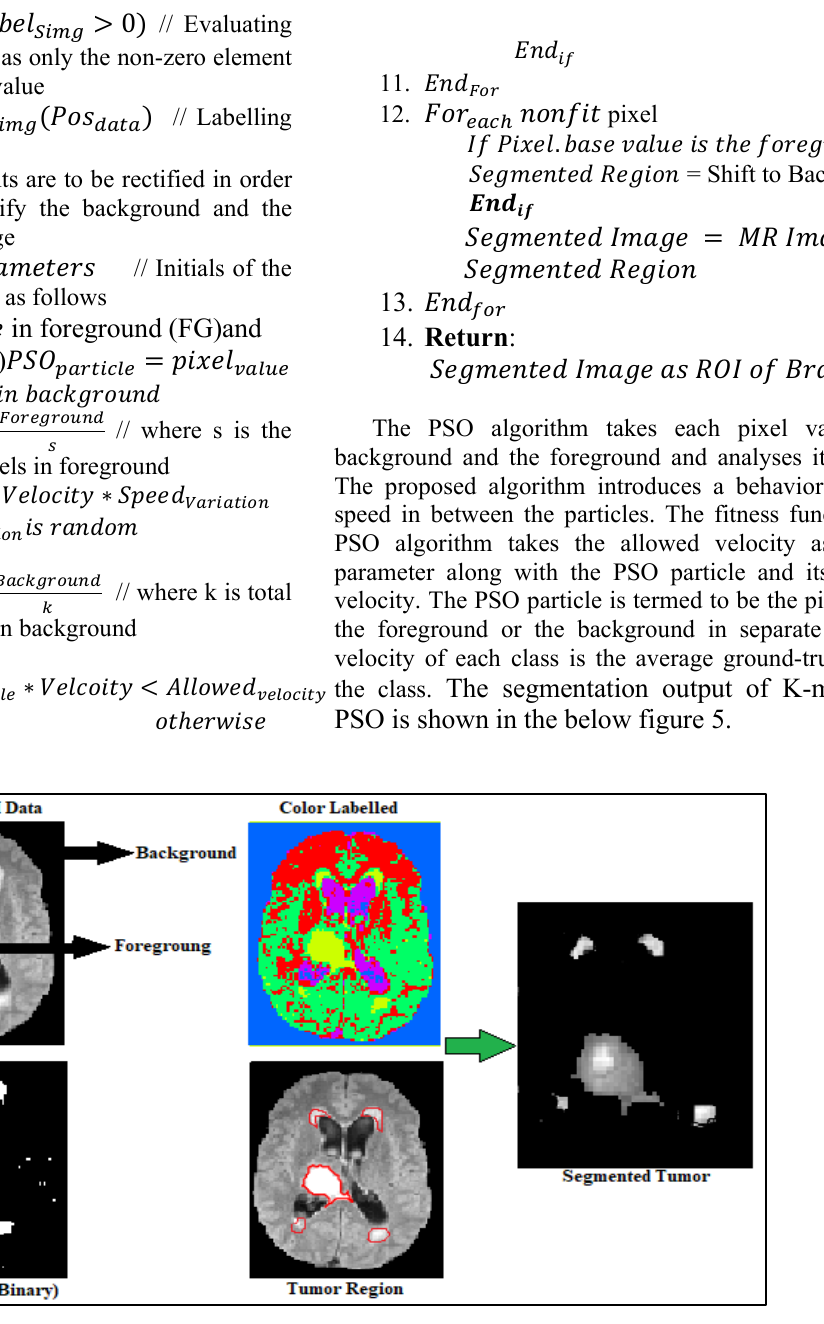
Figure 5. Segmentation using K-means with